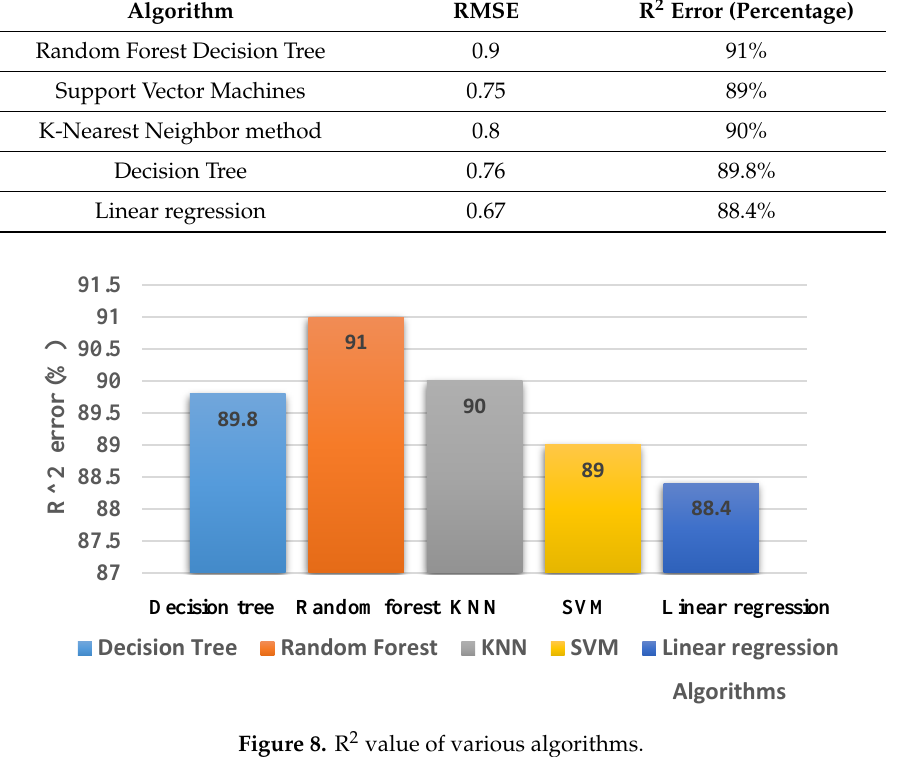
Table 2. Accuracy of various algorithms.